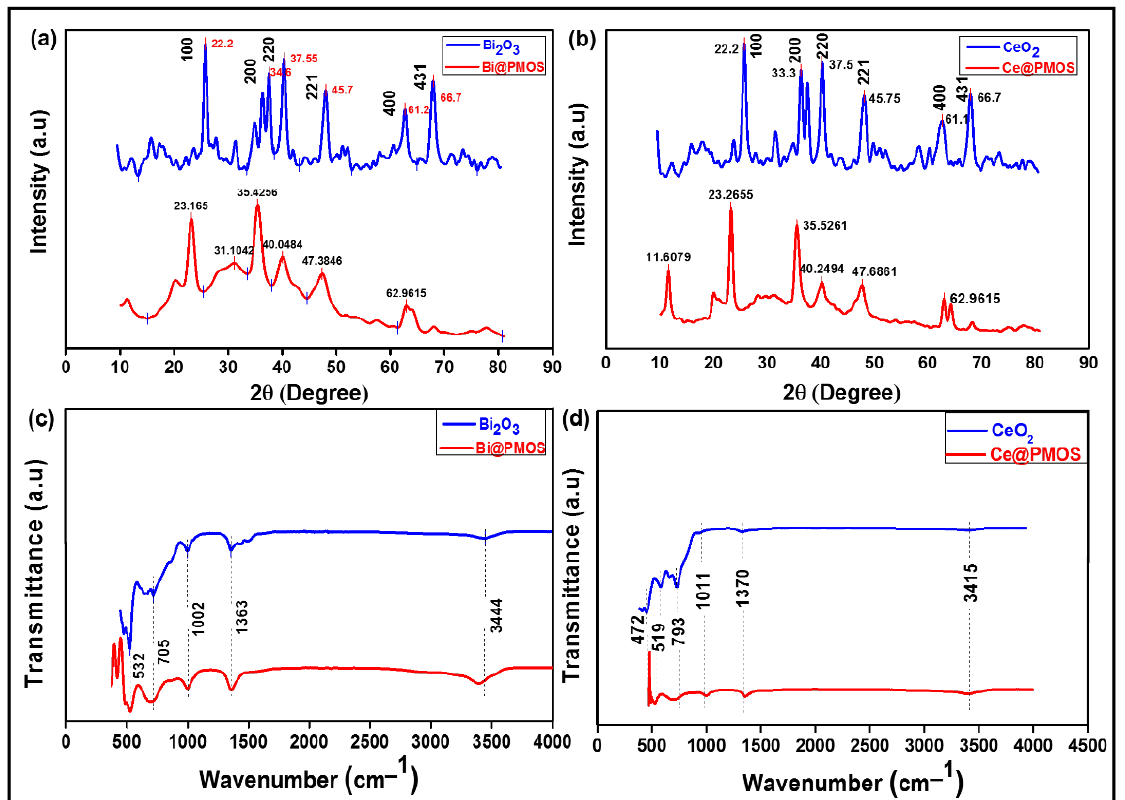
Figure 1. ( a , b ) XRD and ( c , d ) FTIR spectra of Bi@PMOS, Ce@PMOS, Bi 2 O 3 and CeO 2